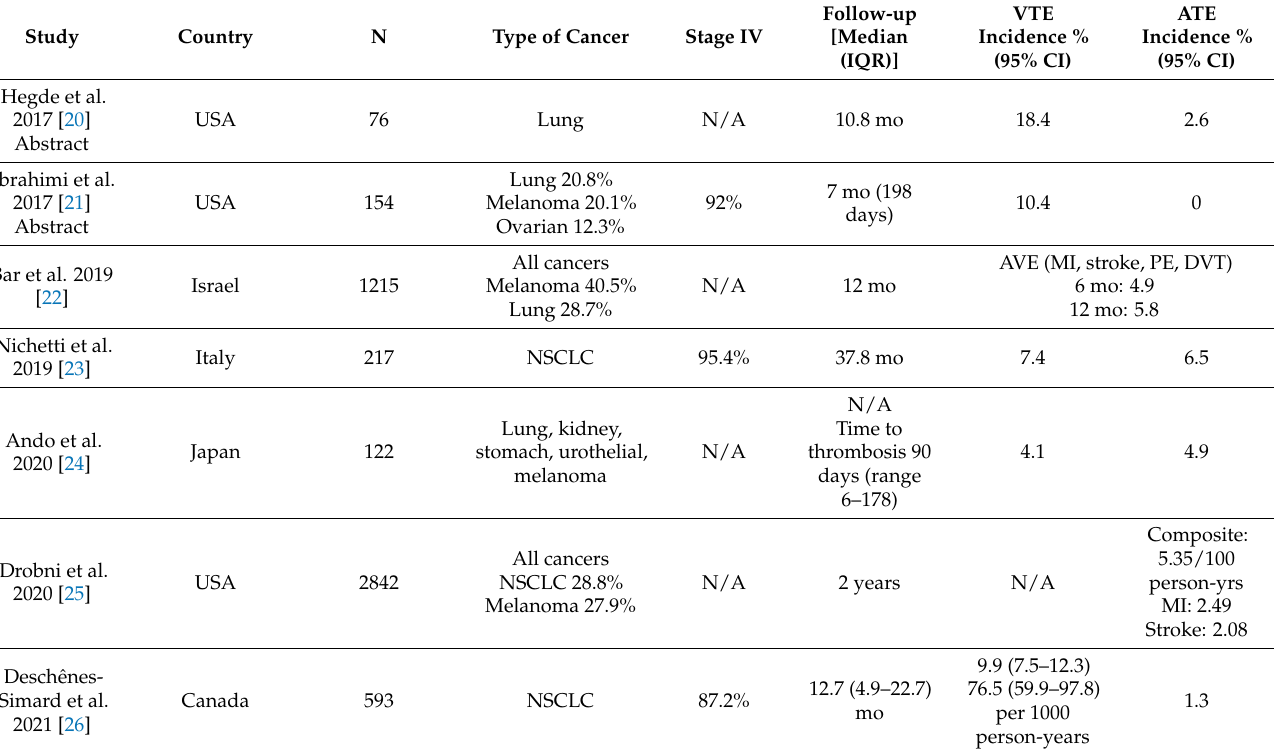
Table 2. Summary of incidence rates of venous and arterial thrombosis from retrospective studies of cancer patients receiving immune checkpoint inhibitors (studies missing follow-up durations were not